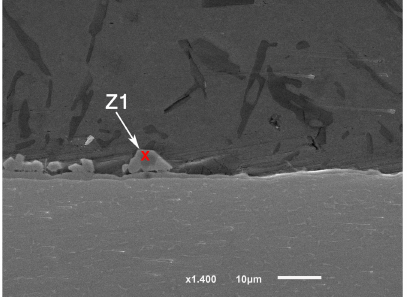
Figure 22. SEM image (SEI) for the joint 13/585L where Z1 is Ti 7 Al 5 Si 12 .